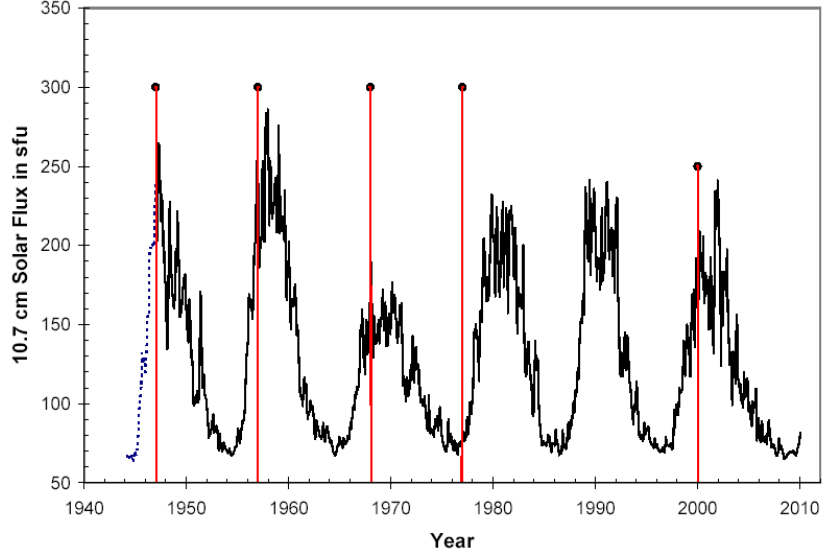
Figure 9. The 1946, 1957, 1968 and 1977 pandemics (shown as spikes) on a plot of the 10.7 cm Solar Flux index. The flux values prior to 1947 (shown dotted) are estimated from sunspot data. (From [86], reproduced by the kind permission of Dr.